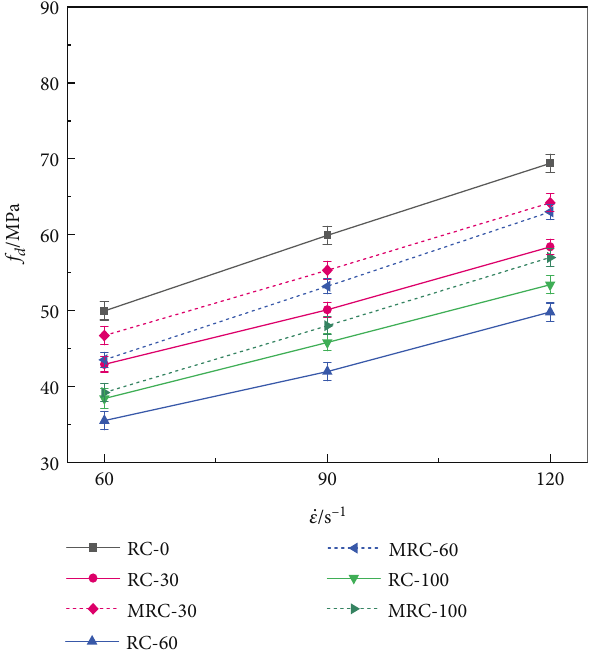
Figure 5: Relationship between the dynamic peak stress and strain